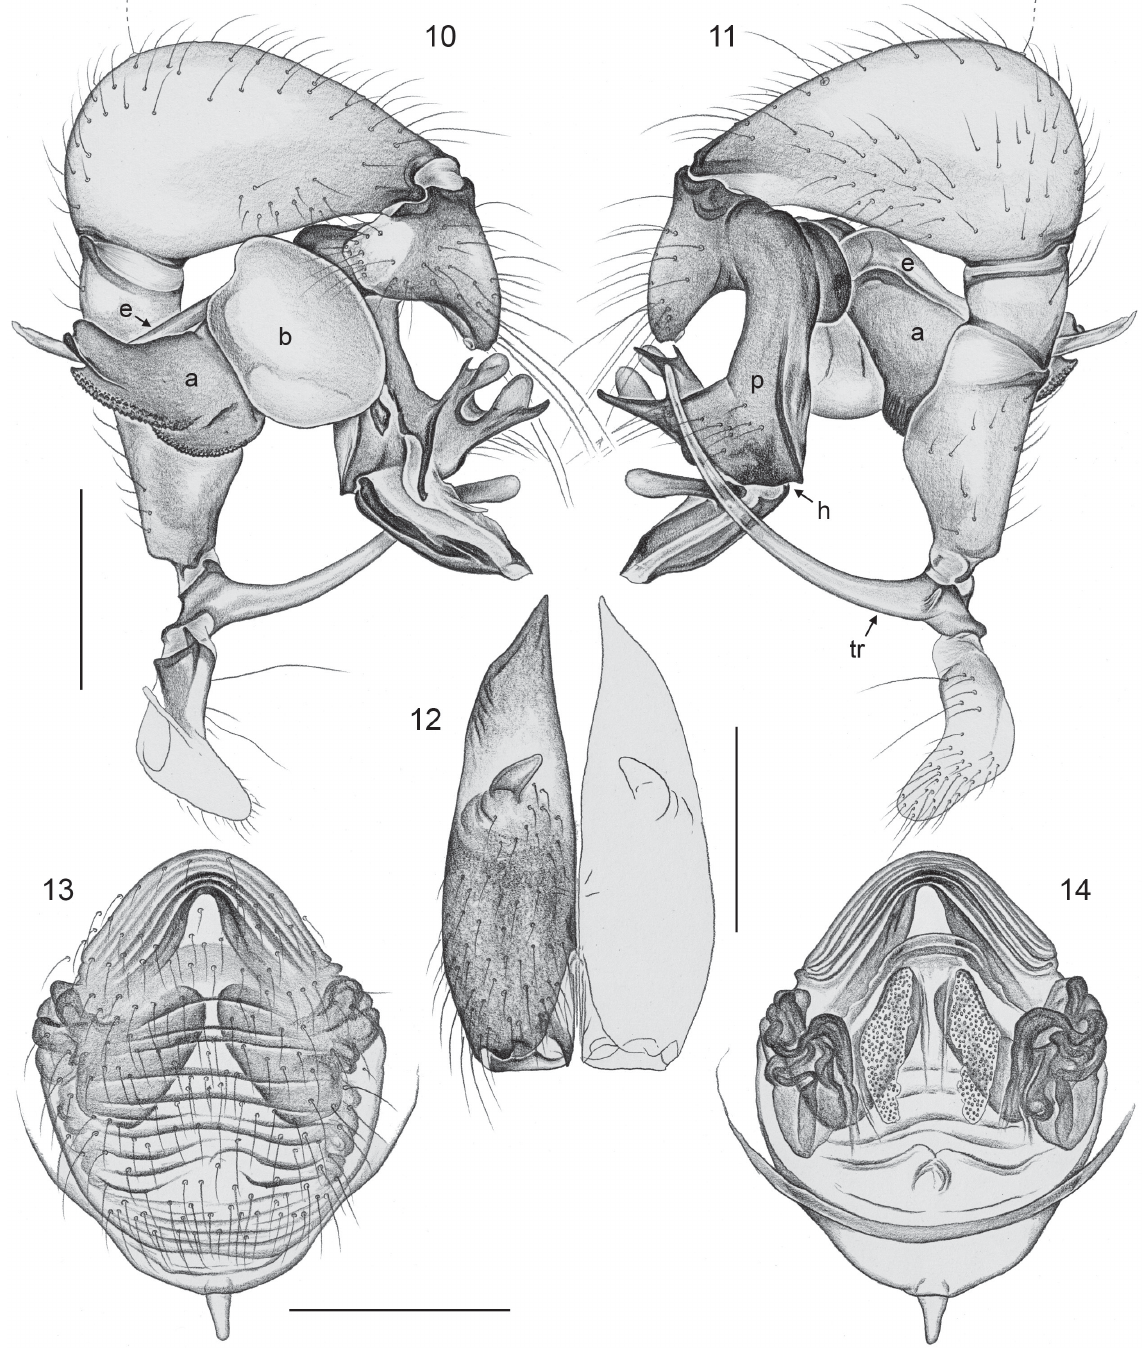
Figs 10–14. Pholcus tanahrata Huber sp. nov. (ZFMK, Ar 15692). 10–11 . Left male palp, prolateral and retrolateral views. 12 . Male chelicerae, frontal view. 13–14 . Cleared female genitalia, ventral and dorsal views. Scale bars: 10–11, 13–14 = 0.5 mm; 12 = 0.3